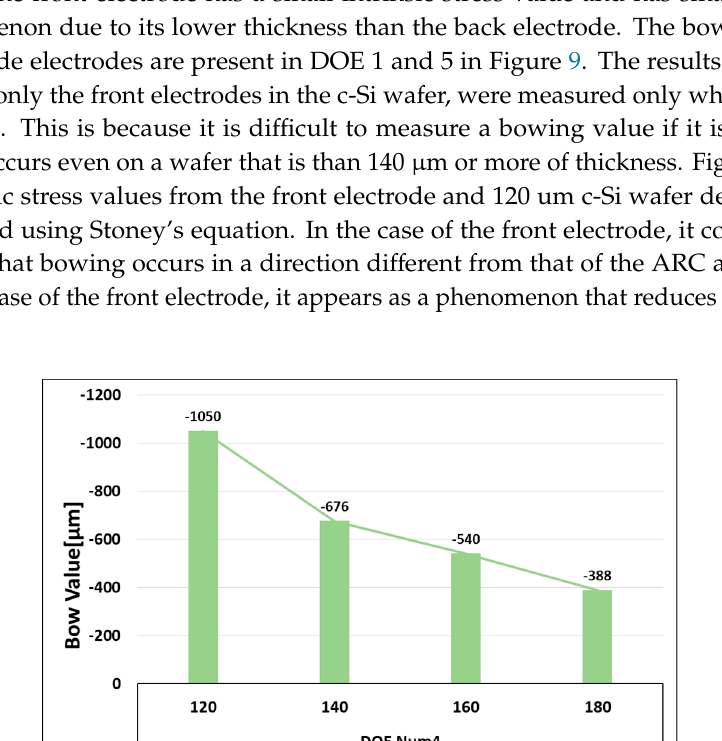
Figure 13. The bowing value and stress value of the back electrode according to change in thickness of the wafer.